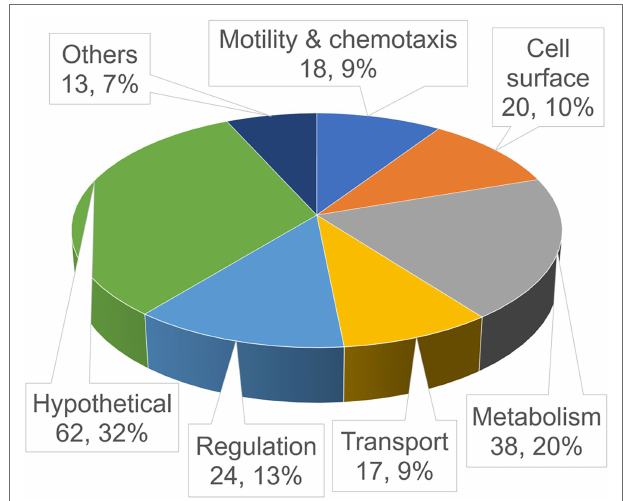
FIGURE 1 | Functional distribution of the identified in-biofilm repressed (ibr) genes. Shown is a pie chart of the validated ibr genes (see also Table 3 ), identified with the TetR-controlled recombination-based in-biofilm expression technology (TRIBET) screening technology, allocated in functional groups by their proposed function according to Kyoto Encyclopedia of Genes and Genomes (KEGG; www.genome.jp/kegg/). The total number and percentage of ibr genes represented in the respective group are indicated by the numbers in